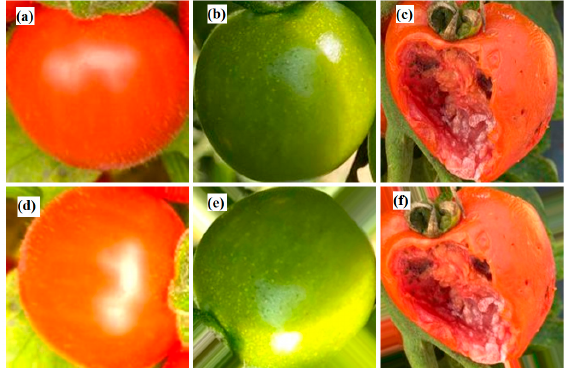
Figure 9. The results after data augmentation. ( a ) Original ripe tomato, ( b ) original immature to- mato, ( c ) original damaged tomato, ( d ) data augmentation of ripe tomato, ( e ) data augmentation of immature tomato, and ( f ) data augmentation of damaged